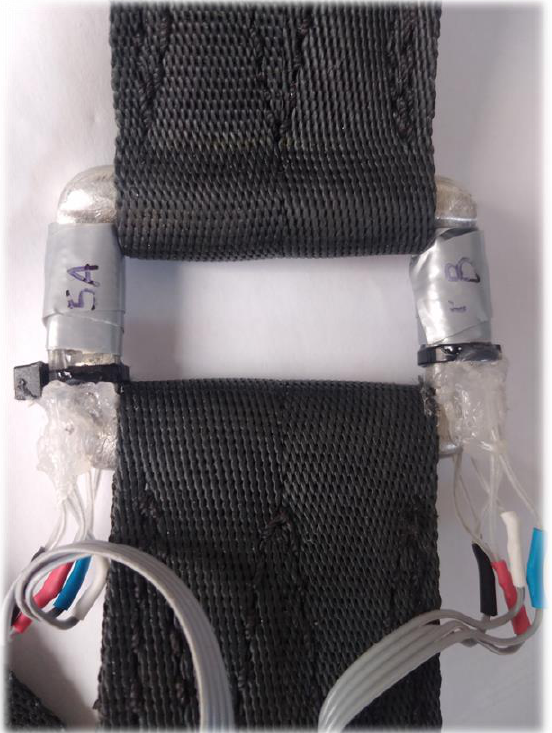
Figure 4. Final load cell manufactured on PS22040-1 baseplate sewn into structure.